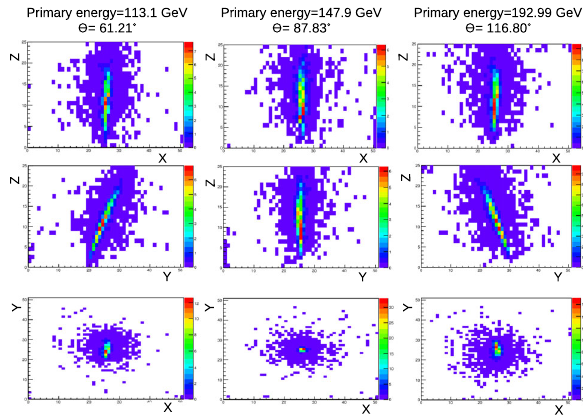
Fig. 8 GANgeneratedelectronswithprimaryenergiesandanglescor- responding to the electrons showed in Fig. 7